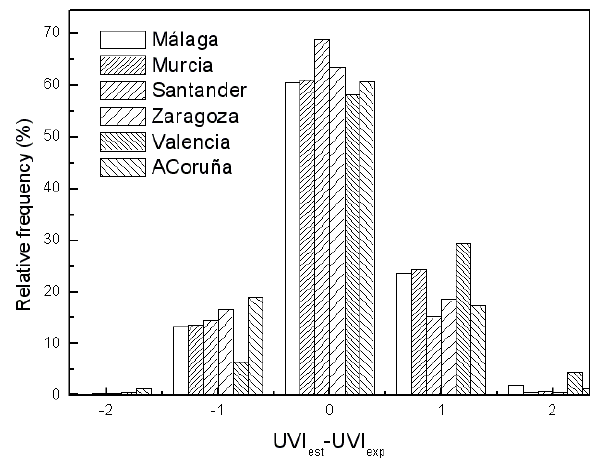
Fig. 5. Histograms of the differences between modeled and esti- mated experimental UVI, at each Figure 5: Histograms of the differences between modeled and estimated experimental UVI, at each location.